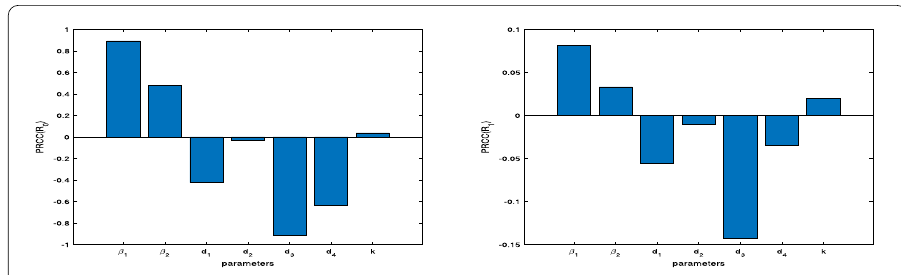
Figure 9 PRCCs of the basic reproduction numbers R 0 and R 1 with respect to some model parameters